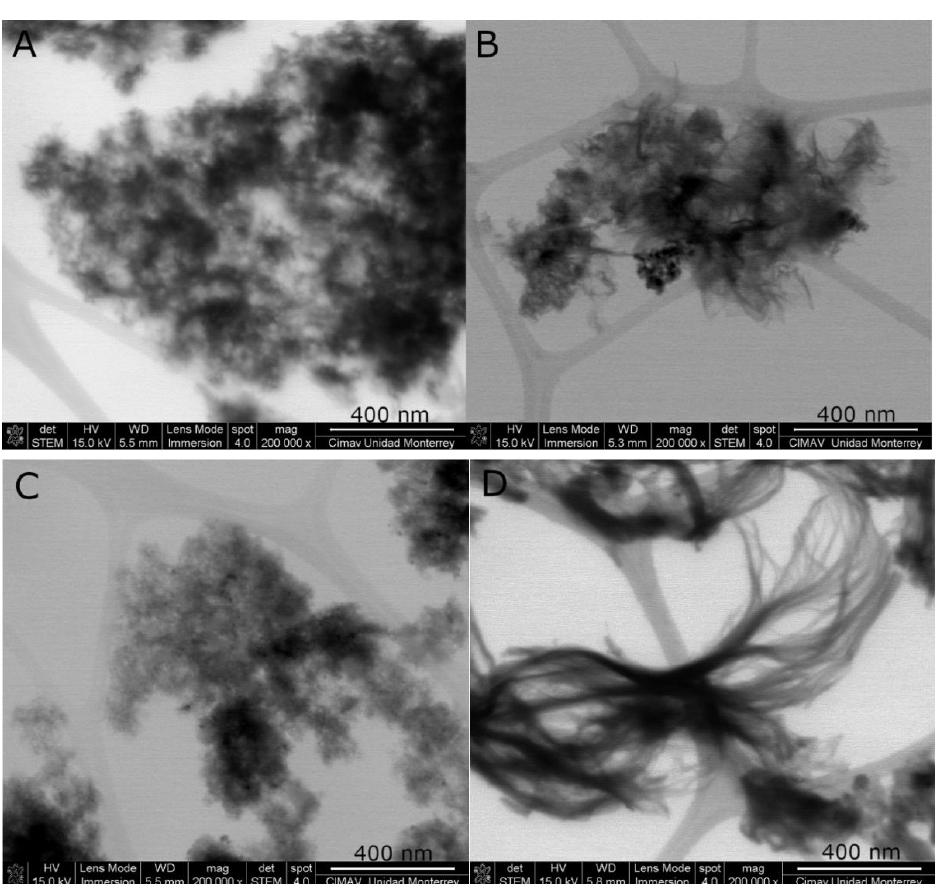
Figure 2. STEM images of Pt-Co 3 O 4 -HSs: PtAq-CoAq ( A ), PtAq-CoOi ( B ), PtOi-CoAq ( C ), PtOi-CoOi ( D ).